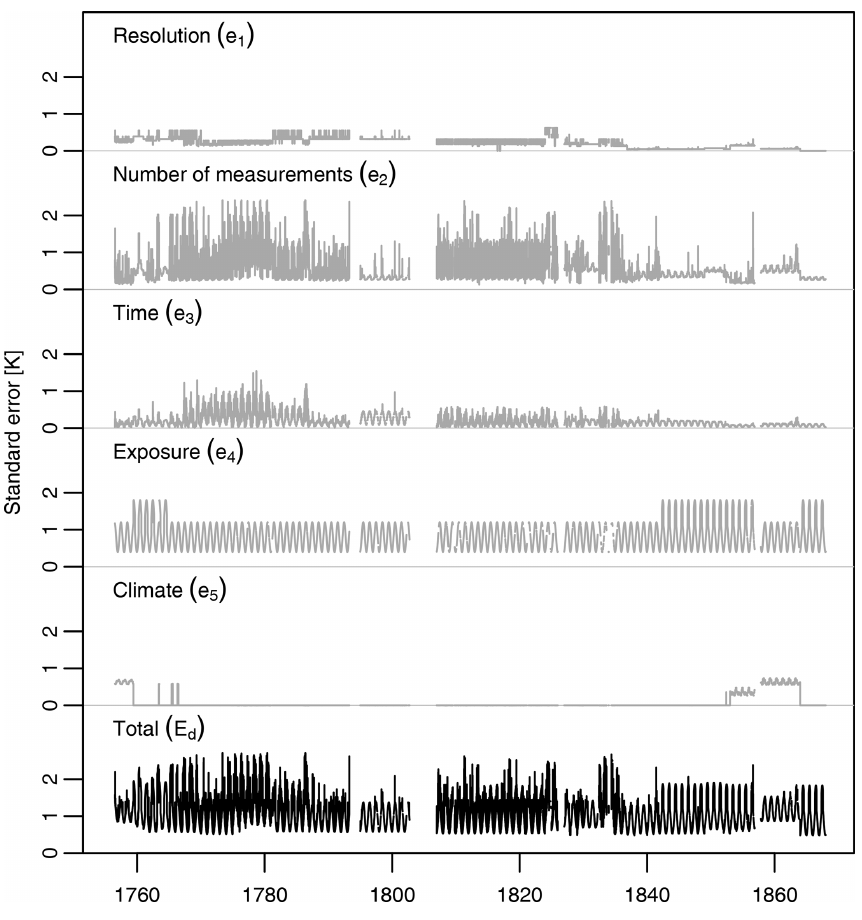
Figure 9. Time evolution of the daily standard error and its components for the merged Zurich